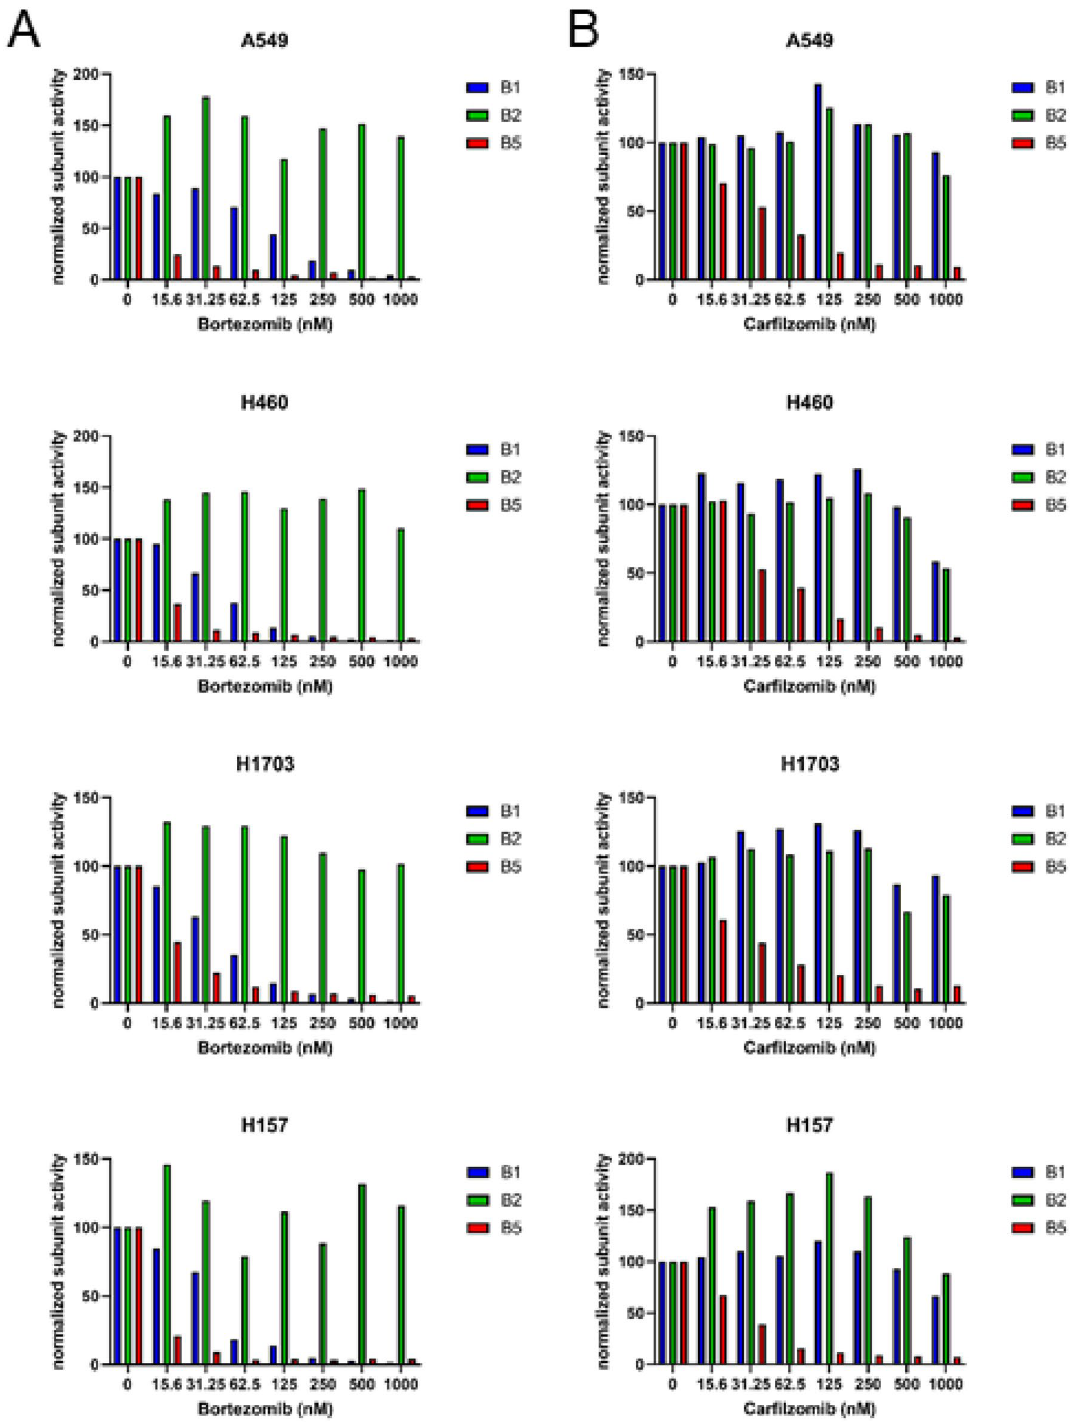
Figure 4. Inhibition of proteasome activity by bortezomib and carfilzomib in NSCLC cell lines. Active site labeling with proteasome subunit-selective probes was performed after ( A ) bortezomib or ( B ) carfilzomib pulse for 1 h in A549, H157, H460 and H1703 cell lines. Proteasome subunits are illustrated in different colors as follows: β1 in blue, β2 in green and β5 in red. Data represent the quantification of one representative experiment out of 3 replicates. The original data are presented in Fig.